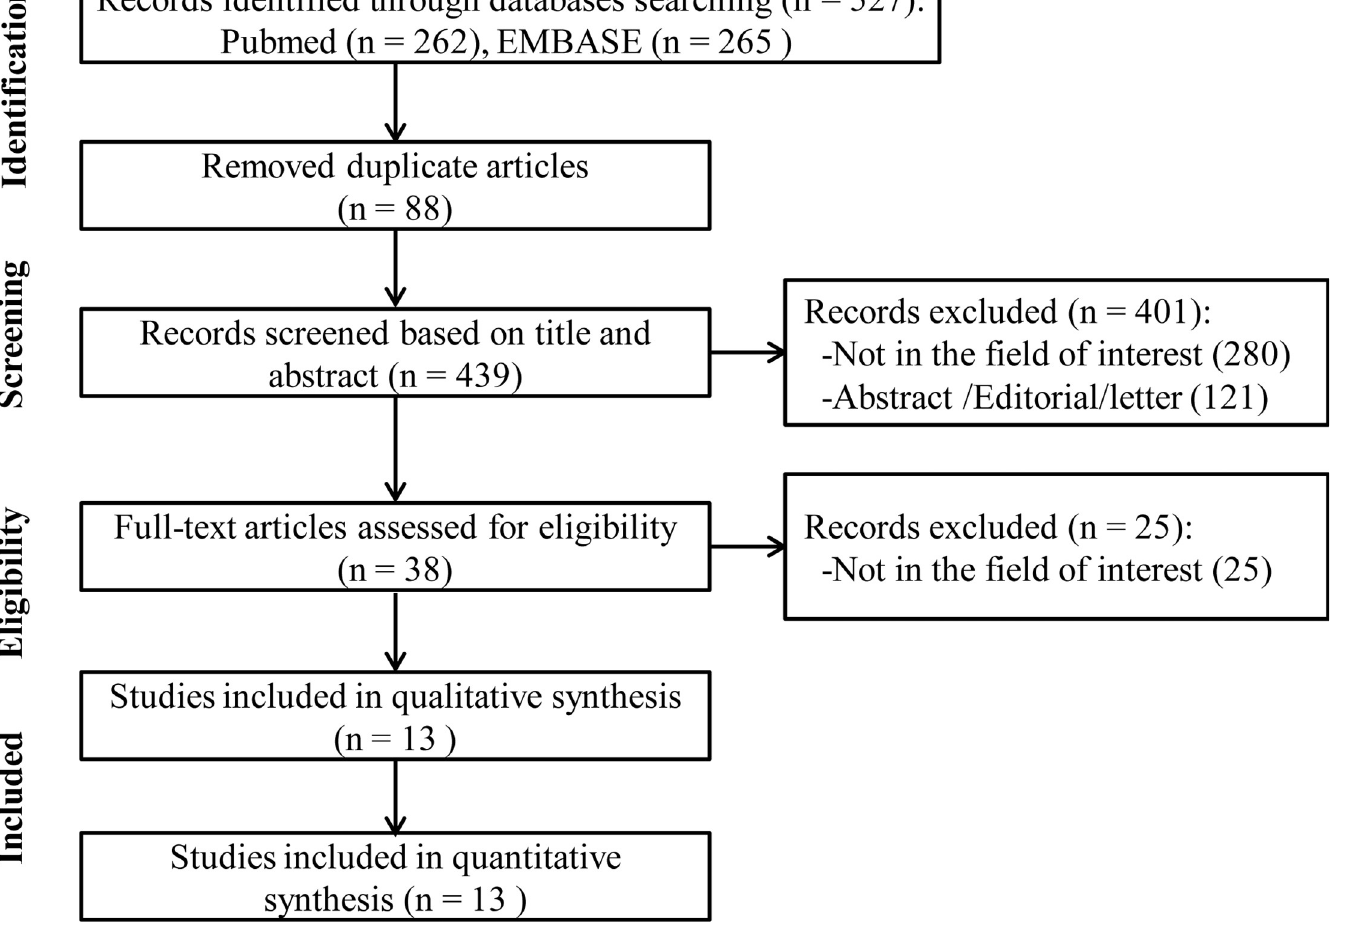
Fig 1. Flow diagram for study selection